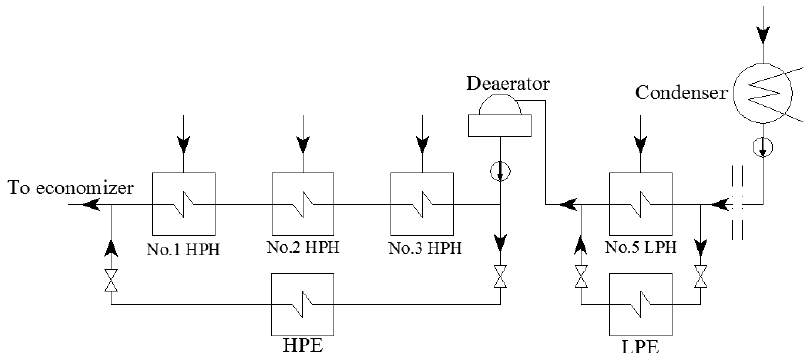
Figure 3. AE position in the regenerative system of a 600 MW unit. HPE: High–Pressure Economizer; LPE: Low–Pressure Economizer; HPH: High–Pressure Heater; LPH: Low–Pressure Heater.